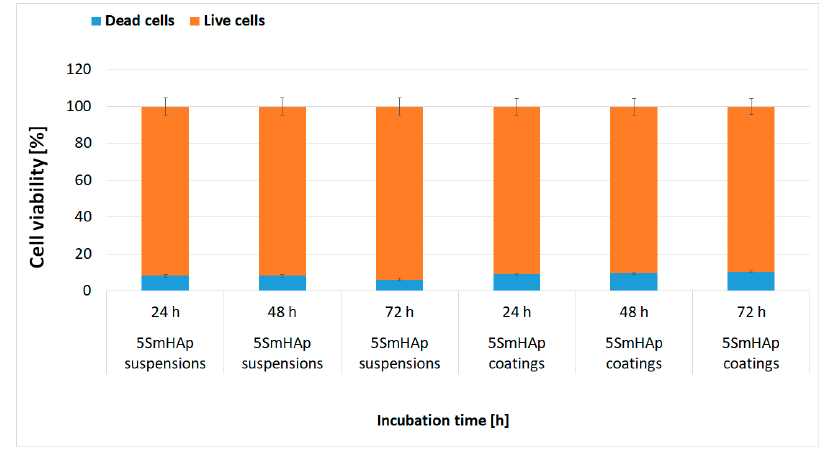
Figure 19. Percent of total counts of live cells and dead cells after incubation with 5SmHAp suspensions and coatings at different time intervals.